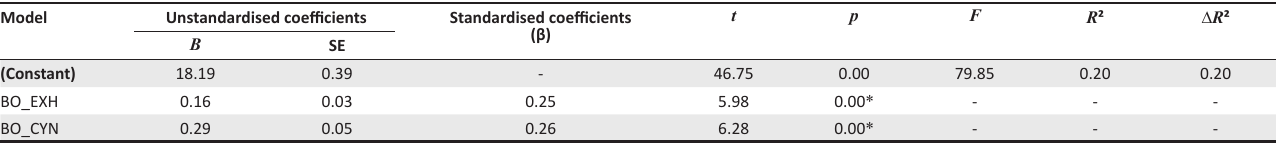
TABLE 6: Multiple regression with social dysfunction (general health) as the dependent variable and emotional exhaustion and cynicism (burnout) as the independent variables.